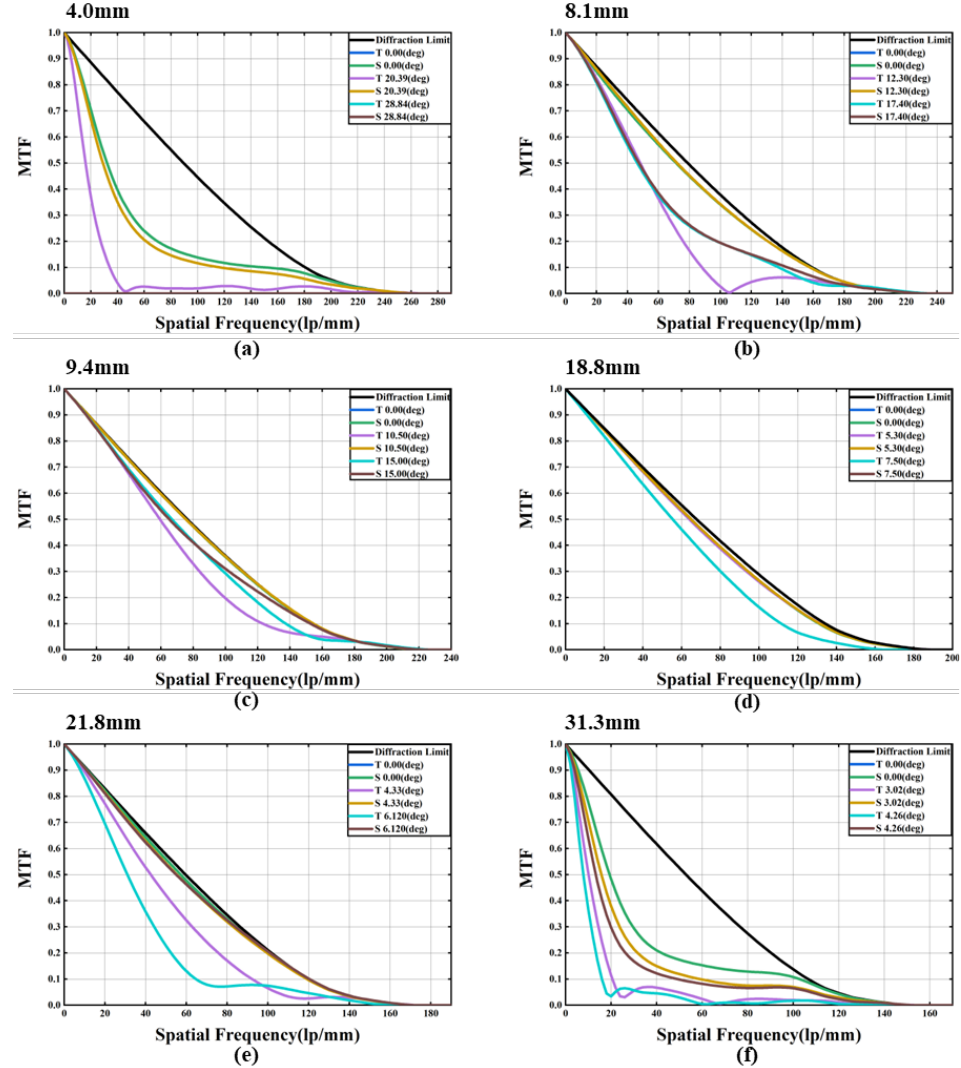
Figure 3. MTF of the proposed zoom system in the whole tuning range. “T” represents the tangential direction, and “S” represents the sagittal direction. ( a ) f = 4.0 mm. ( b ) f = 8.1 mm. ( c ) f = 9.4 mm. ( d ) f = 18.8 mm. ( e ) f = 21.8 mm. ( f ) f = 31.3 mm.